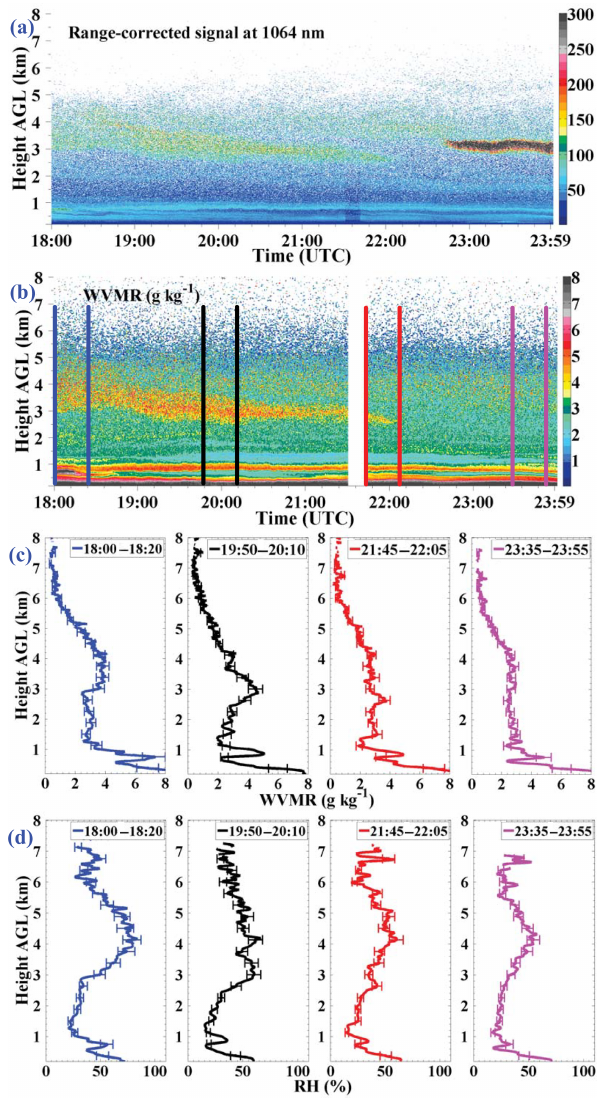
Figure 11. Temporal development of the (a) range-corrected sig- nal at 1064nm and (b) water vapor mixing ratio measured on 20 April 2017. (c) Four water vapor mixing ratio profiles and (d) rel- ative humidity profiles during the periods marked in panel (b) are shown. The temporal resolution for the range-corrected signal and water vapor mixing ratio measurements is 30s. The integral time of water vapor mixing ratio profiles and relative humidity profiles in panels (c) and (d) is 20min.